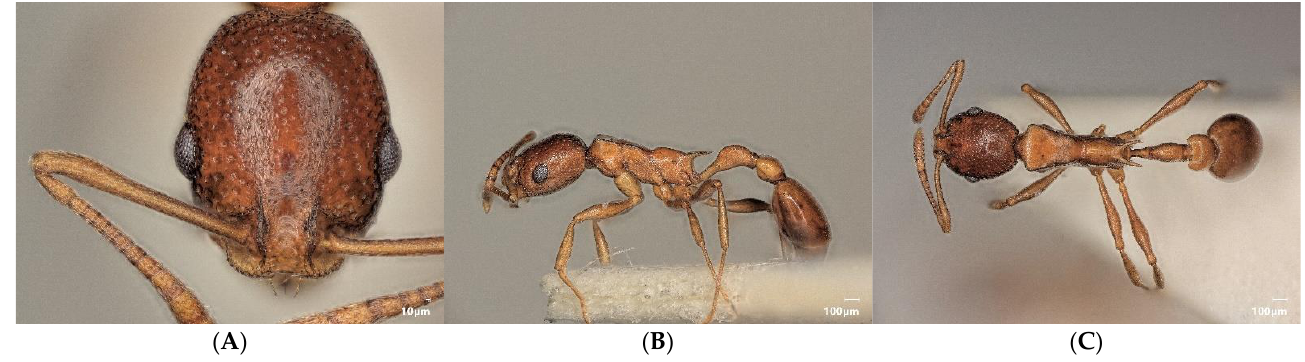
Figure 23. Cardiocondyla paradoxa : head in dorsal view ( A ), lateral view ( B ), dorsal view ( C ).